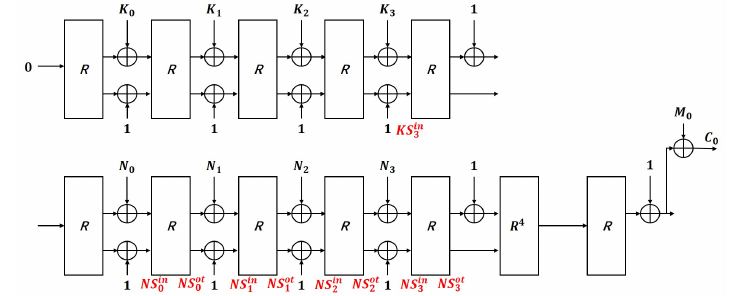
Figure 9: Key recovery